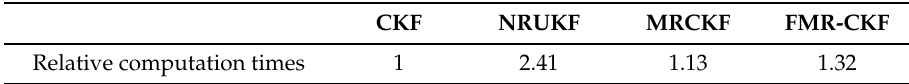
Table 1. Relative computation times of the